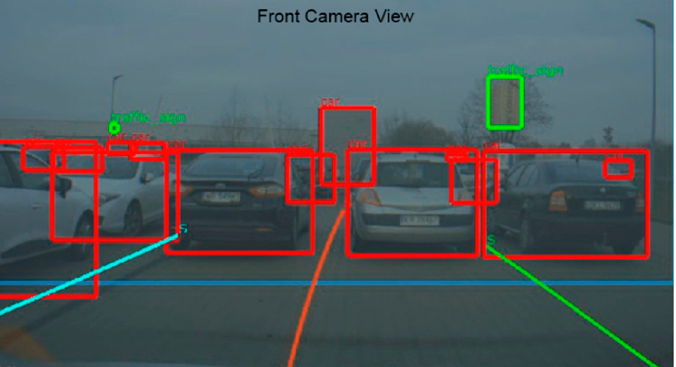
Figure 16. Car front camera view from the same point in time as in Figure 17.